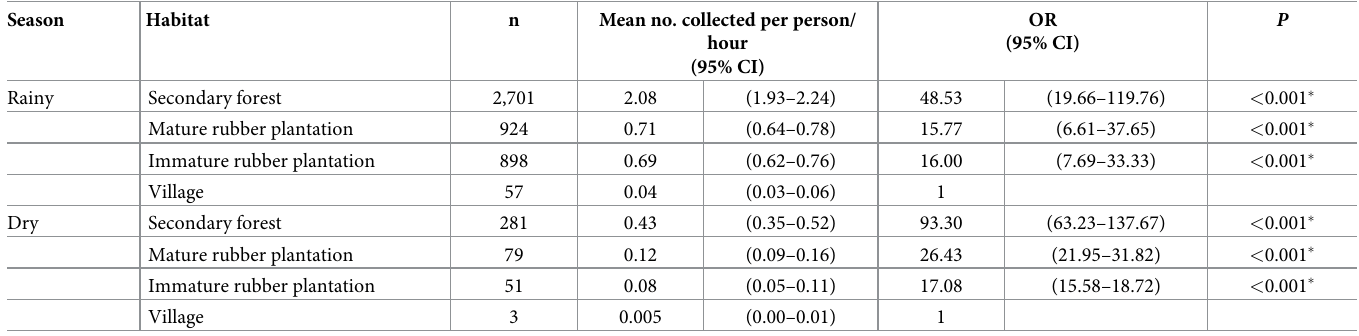
Table 1. Multivariate analysis of habitat variability associated with female Ae . albopictus collected using human-baited double net traps during day-time from 06.00 to 18.00 h during the rainy season (April to October) and dry season (November to March).